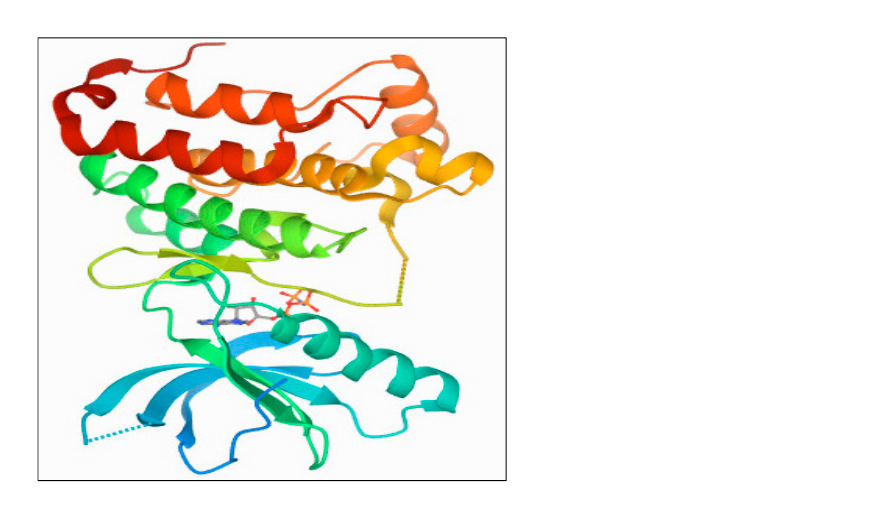
Figure 11. X-ray crystal structures of Aurora-A protein kinase (PDB 1MQ4) tyrosine kinase family protein.